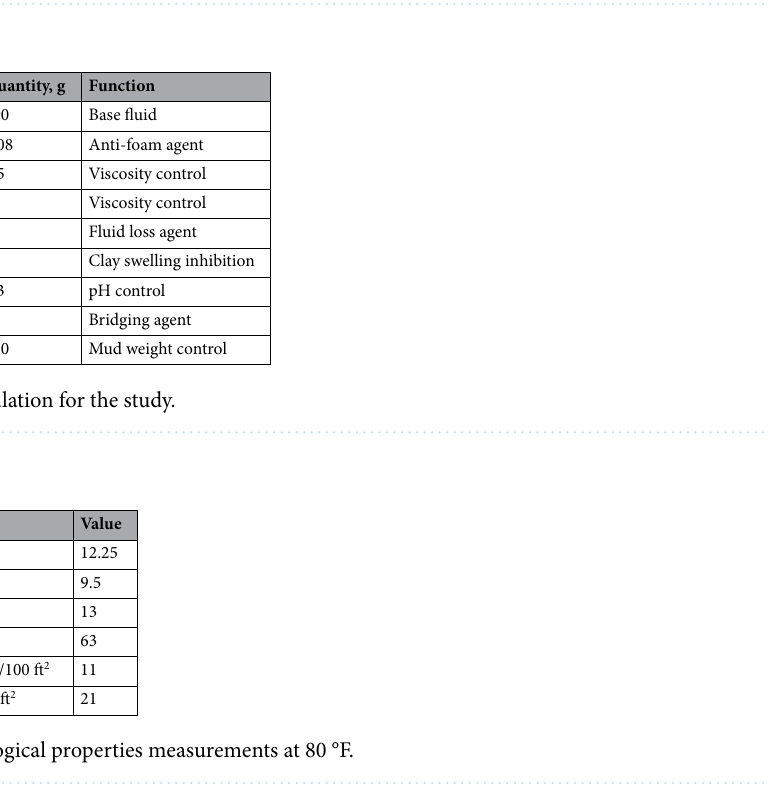
Figure 3. Schematic for the modified cell for the filtration test.